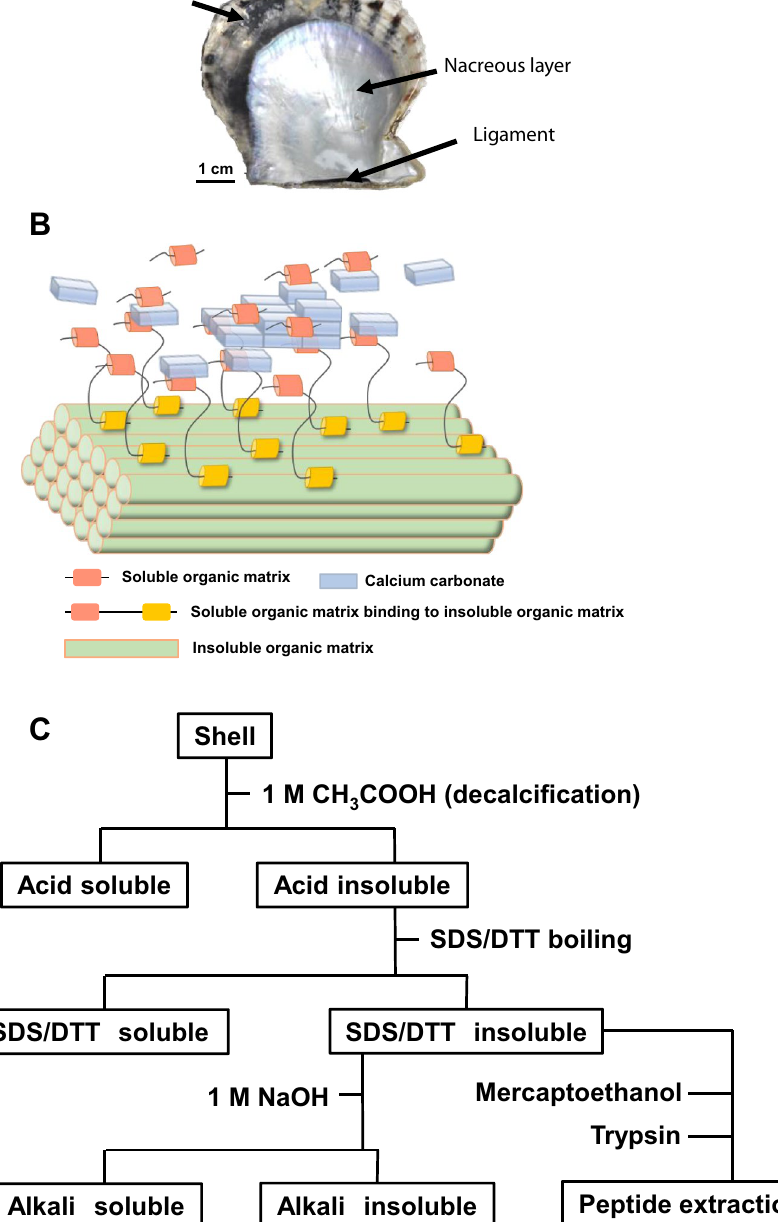
Figure 1. ( A ) Shell structure of Pinctada fucata . ( B ) A model for a hierarchical structure of organic matrices. The insoluble organic matrices containing chitin become the scaffold. A nucleation of calcium carbonate occurs around the insoluble organic matrices mediated by the soluble organic matrices which have chitin binding domain (yellow) and calcium carbonate-interaction domain such as acid-rich domain (pink). Other soluble organic matrices control the crystal growth. ( C ) A flow chart for the extraction of organic